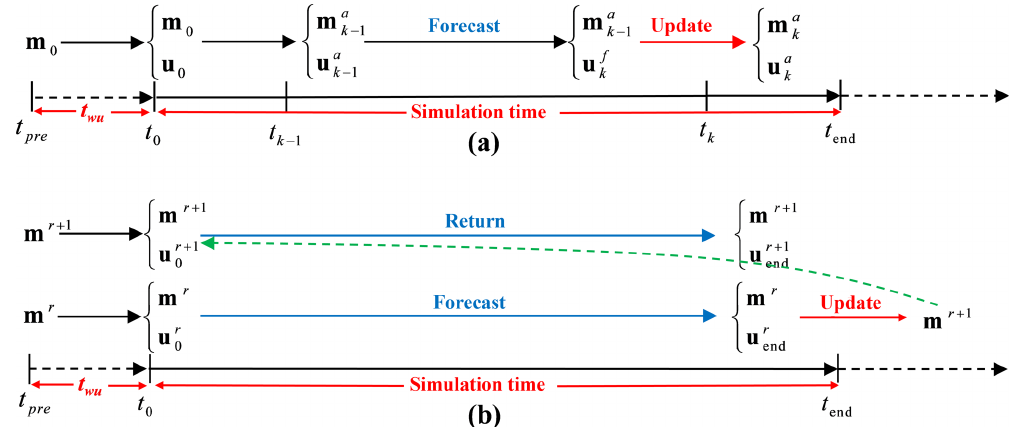
Figure 1. Flow charts of simulation period – or data assimilation period with (a) ensemble Kalman filter (EnKF) and (b) iterative ensemble smoother (IES) – and warm-up period. t 0 is the initial time, and t end is the end of simulation time. m k and u k are the vectors of model parameters (e.g., hydraulic conductivity) and state variables (e.g., soil moisture), respectively, at time t k , while m r and u r are the vectors at iteration r ; the superscripts “a” and “f” refer to model analysis and forecast (or initial guess). Besides this, the period between t pre and t 0 donates the process of warming up, and t wu is the required warm-up time.